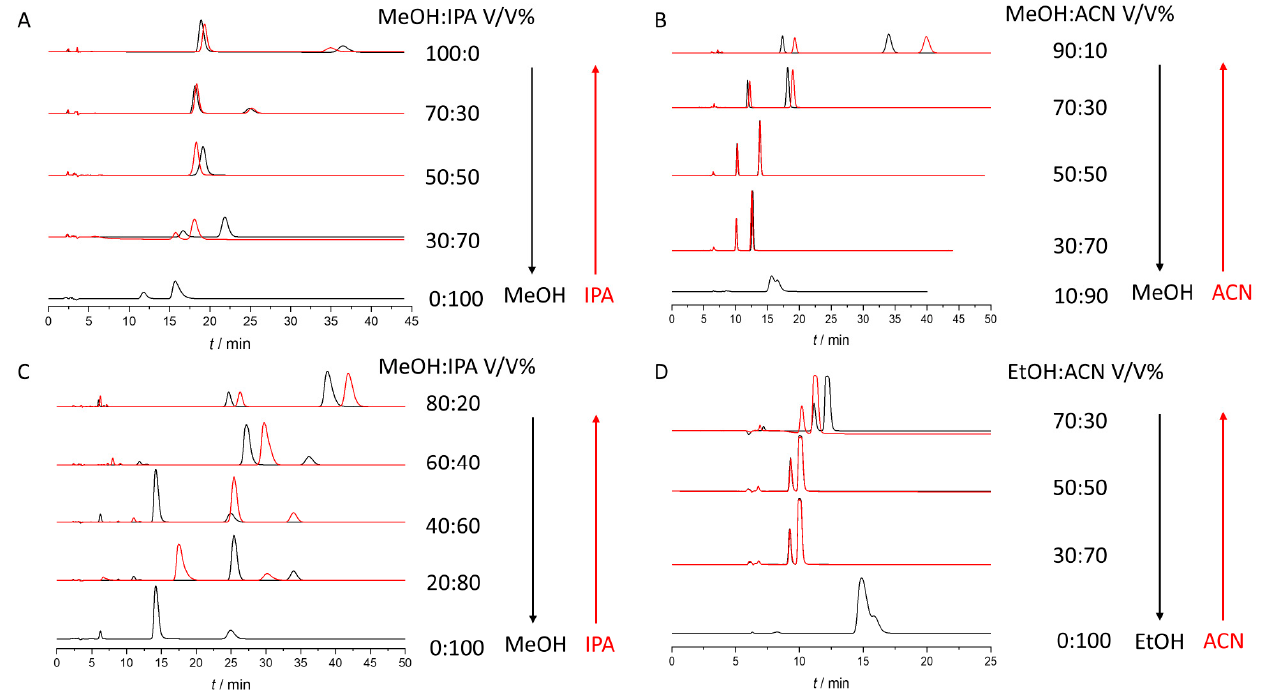
Figure 6. Chromatograms observed in different eluent compositions during the hysteresis study. ( A ): Enantioseparation of POM in different MeOH/IPA eluent mixtures using Chiralpak AD, ( B ): Enantioseparation of THAL in different MeOH/ACN eluent mixtures using Chiralpak AD, ( C ): Enantioseparation of THAL in different MeOH/IPA eluent mixtures using Chiralpak AD ( D ): Enantioseparation of THAL in different EtOH/ACN eluent mixtures using Chiralpak AD.